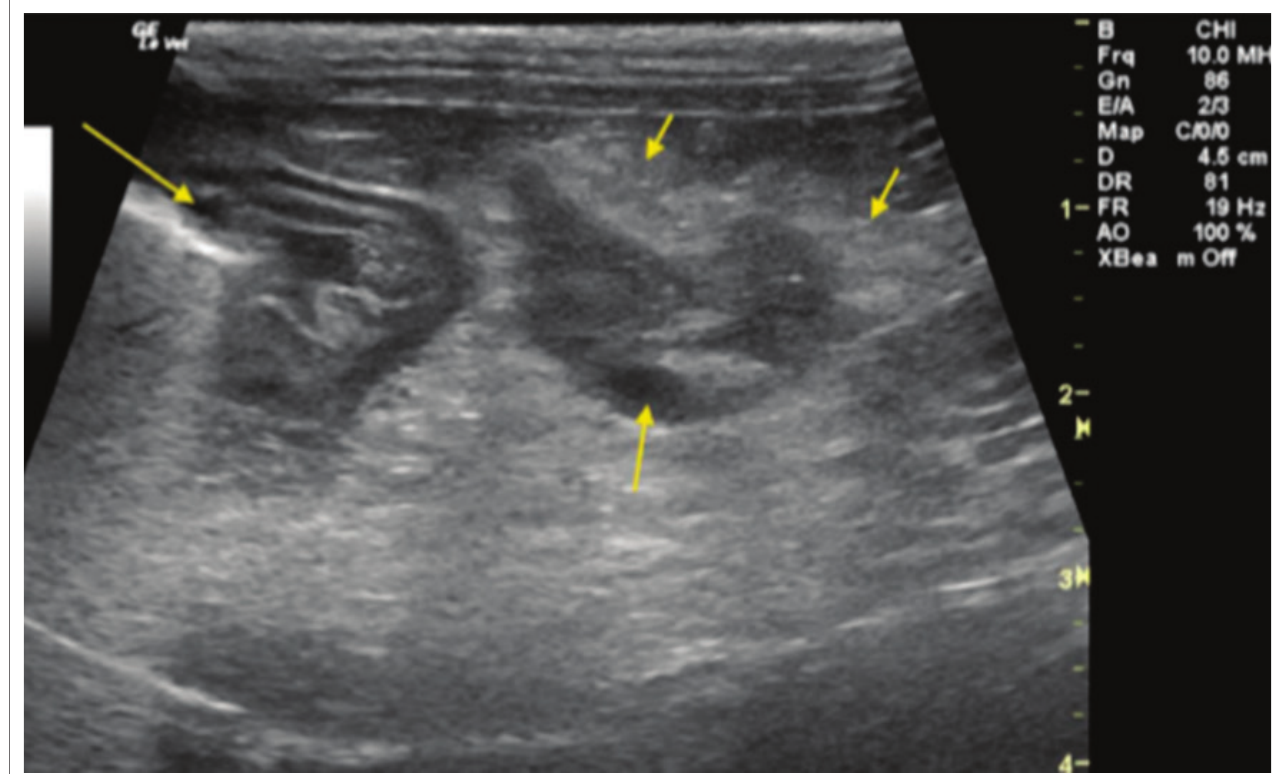
FIGURE 1: Example of pancreatitis affecting the left limb of the pancreas (group 1): Focal mixed hypoechoic lesion (middle arrow) in the near field at the base of the left pancreatic limb. Low-grade ill-defined inflamed fat (small arrows) is noted bordering the hypoechoic pancreatic parenchyma typical of pancreatitis. The location is caudal to the gastric fundus (long arrow) free from influence upon the duodenum or pyloric